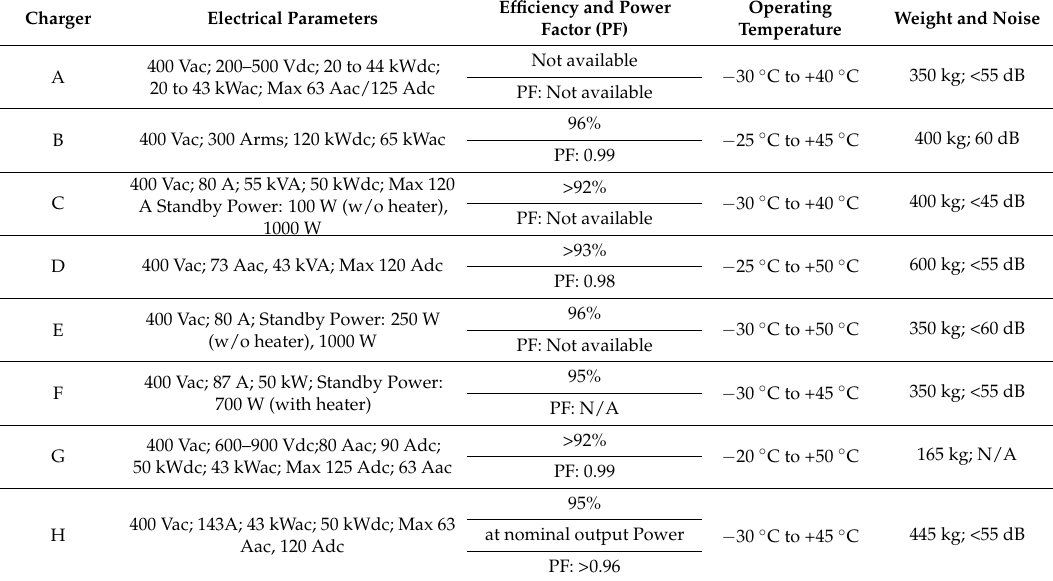
Table 1. Chargers’ main specifications [17].